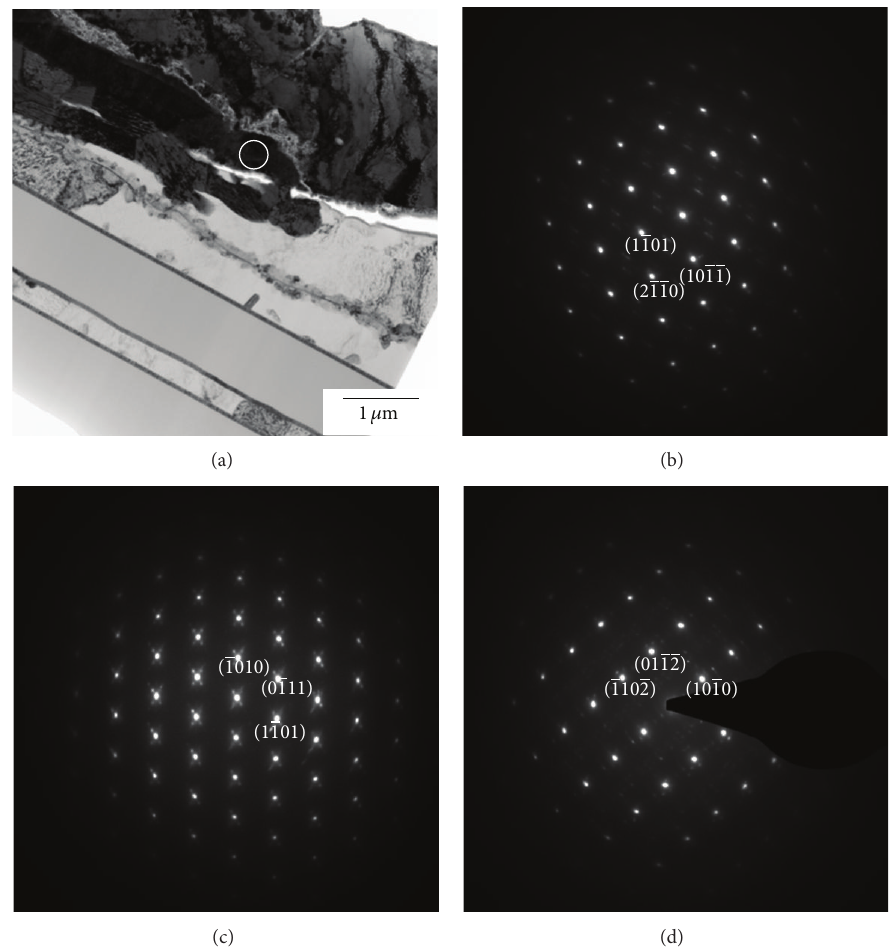
Figure 6: IMCs above the bonding interface were found to be (Ag, Au, Pd) 2 Al (hexagonal structure).